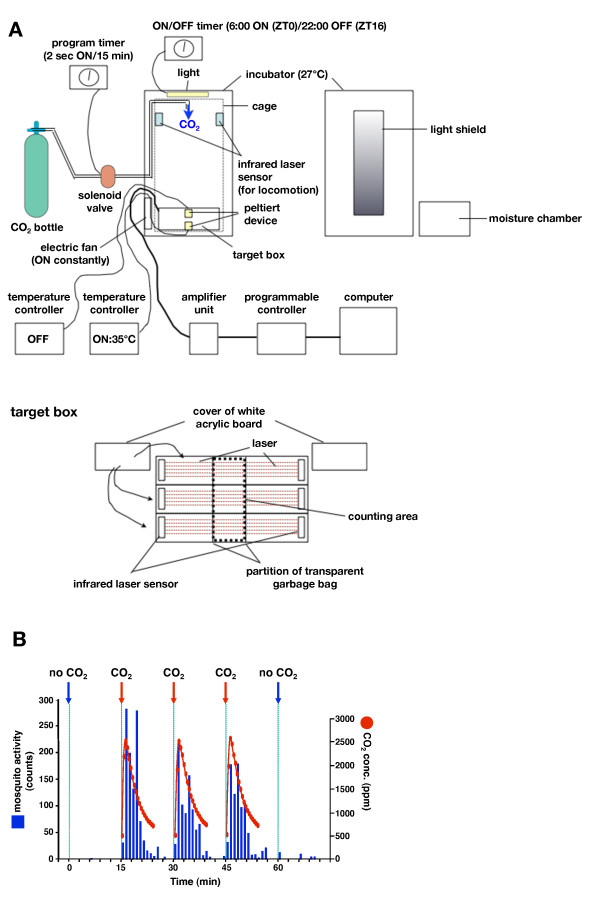
Automated-recording device for quantifying the selected host-seeking behavior. (A) Schematic view of the recording device to quantify mosquito activity patterns (see Materials and Methods). (B) An example of the selected host-seeking behavior of 60 female mosquitoes monitored for a short period (75 min) by automated-device shown in (A). CO2 was delivered for 2 sec at 15 min, 30 min, and 45 min (arrow). Note that female mosquitoes show "touch-down" behavior (blue) on the Peltier plate in response to the change of CO2 concentration (red).